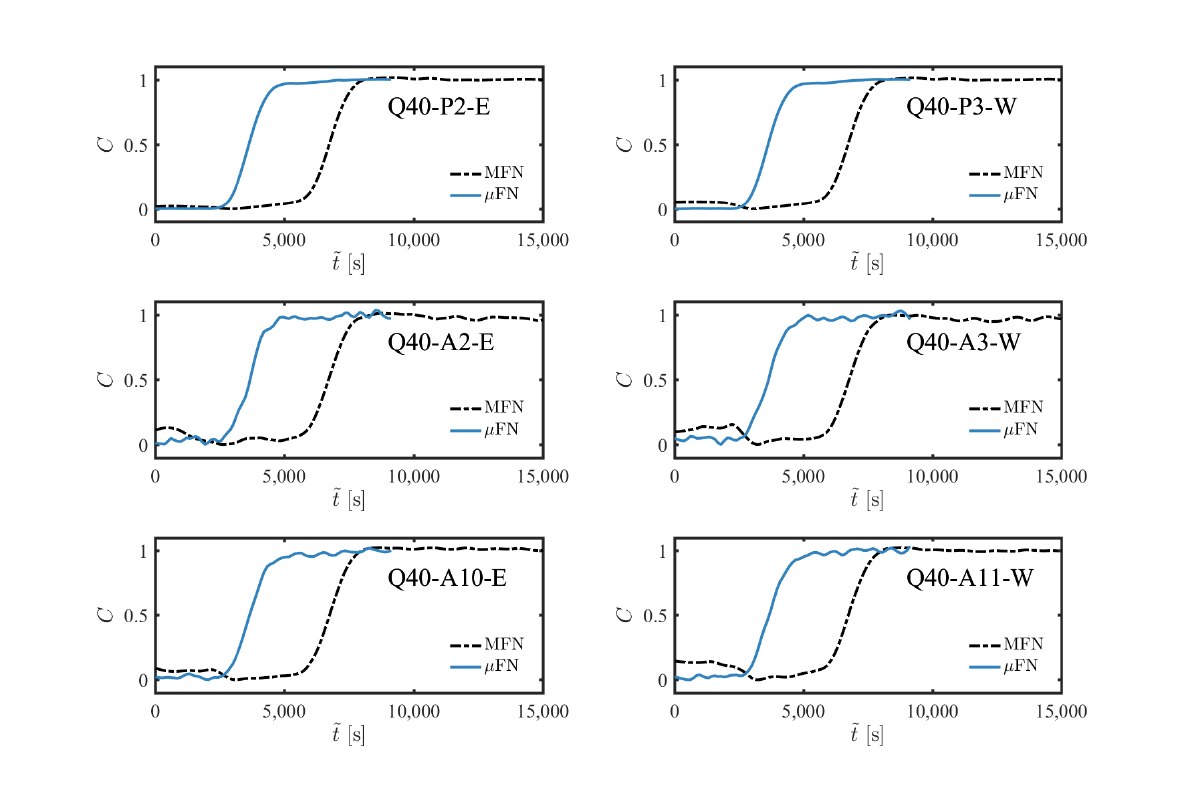
Figure A11. Breakthrough curves measured in physical time in the MFN (dashed line) and µ FN (solid line) at upstream (east) and downstream (west) locations on the same primary (P2–P3), secondary (A10–A11) and tertiary (A2–A3) fracture at Q = 40 µ